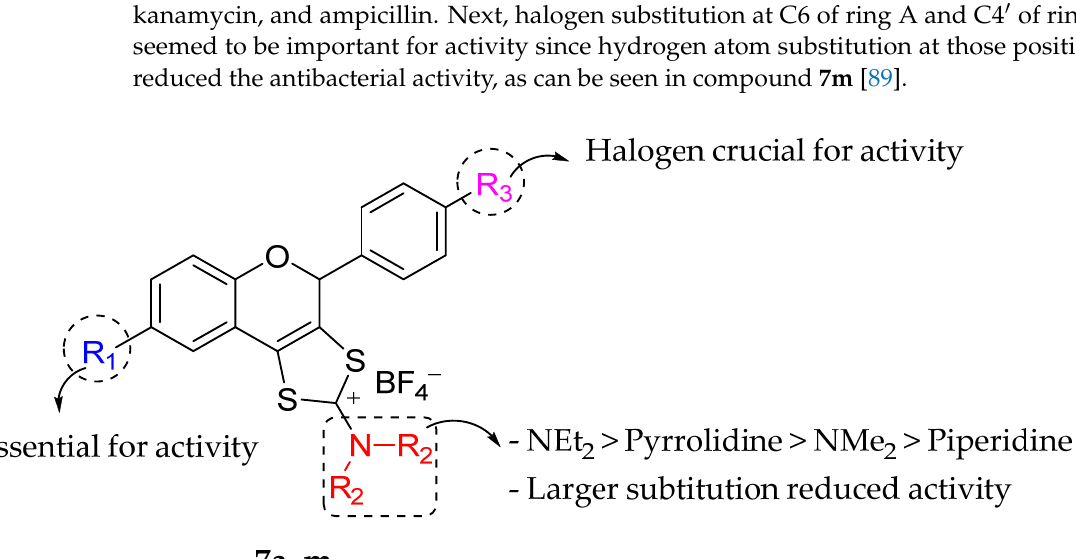
Figure 23. SAR analysis of sulfur-containing tricyclic flavonoids against S. aureus and E. coli [89]. Farooq et al. (2020) synthesized three chalcone derivatives and evaluated their an- tibacterial action against S. aureus via disc diffusion assay and turbidimetric kinetics. The Table 14 shows that all three compounds exhibited good antibacterial properties, especially 4-( € -3-(4-Fluorophenyl)-3-oxoprop-1-enyl)benzoic acid ( 8b ). It can be seen that 8b exerted the maximum zone inhibition and the lowest MIC value compared to other synthesized compounds. 8b was also outperformed the commercially available antibiotic ampicillin in terms of zone inhibition. The summary of SAR analysis is illustrated in Figure 24. The authors discussed that good antibacterial activity exerted by these compounds was due to the presence of COOH moiety at C2 (cid:48) of ring B [90]. Then, as previously stated, 8b demonstrated the highest activity, attributed to the fluorine substituent at C6 of ring A [91]. The authors discussed that higher electronegative substitution improved the antibacterial action